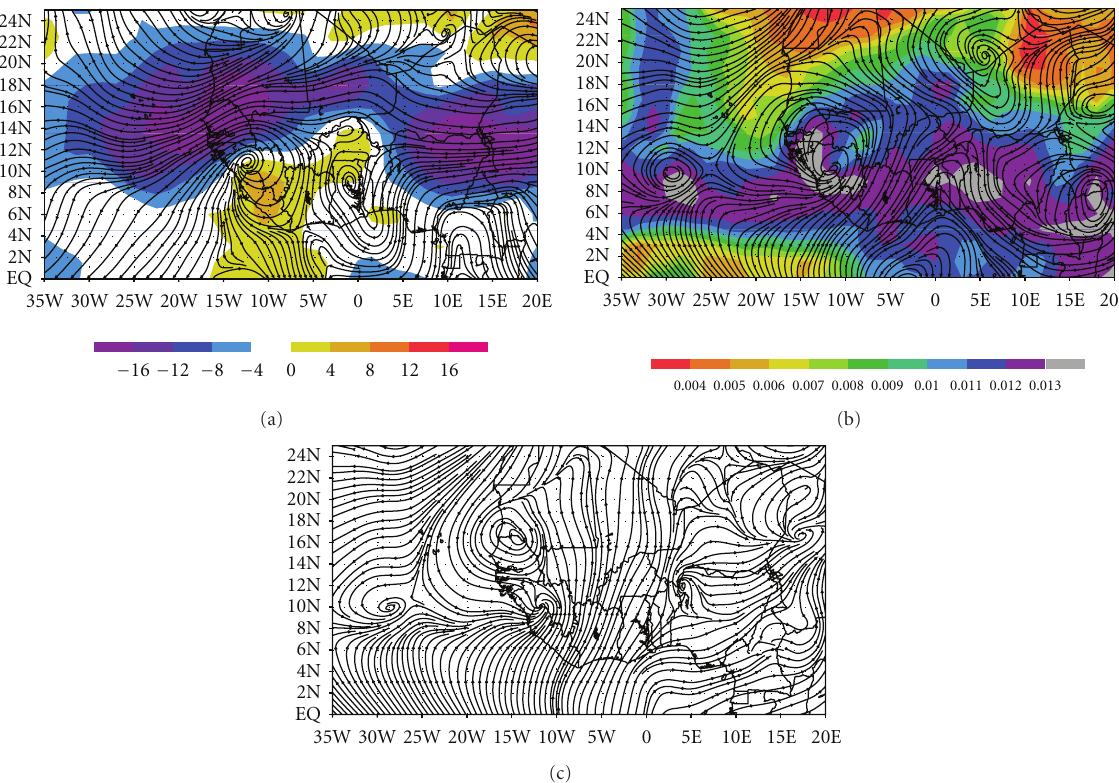
Figure 4: (a) Composite ECMWF Reanalysis zonal winds (ms − 1 ) and streamlines at 0600 UTC 11 September for 650 hPa. (b) Composite ECMWF Reanalysis at 0600 UTC 11 September for 850 hPa, specific humidity (kgkg − 1 ) and streamlines. (c) Composite ECMWF Reanalysis streamlines at 0600 UTC 11 September for 925